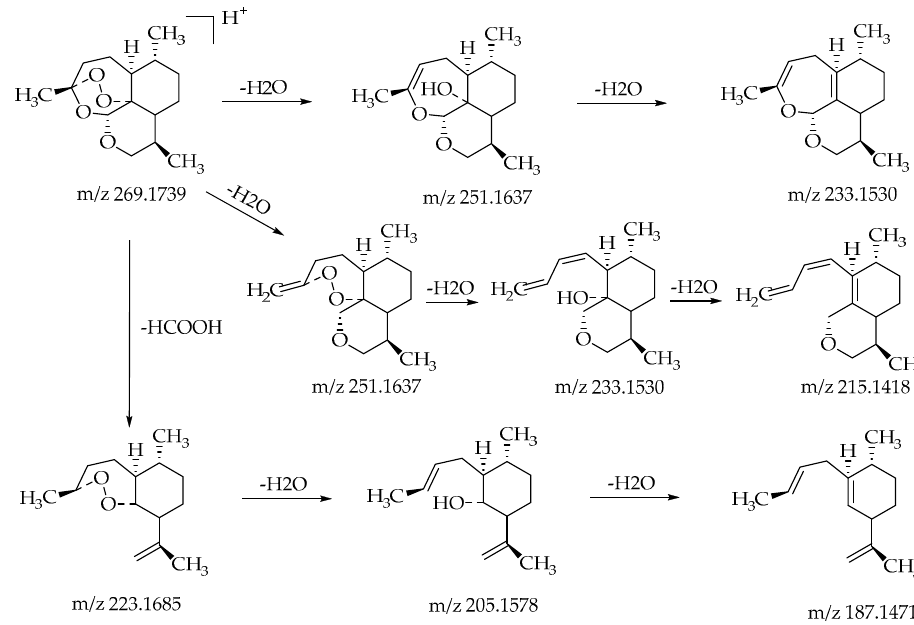
Figure 3. Proposed fragmentation pathways of 10-deoxoartemisinin.